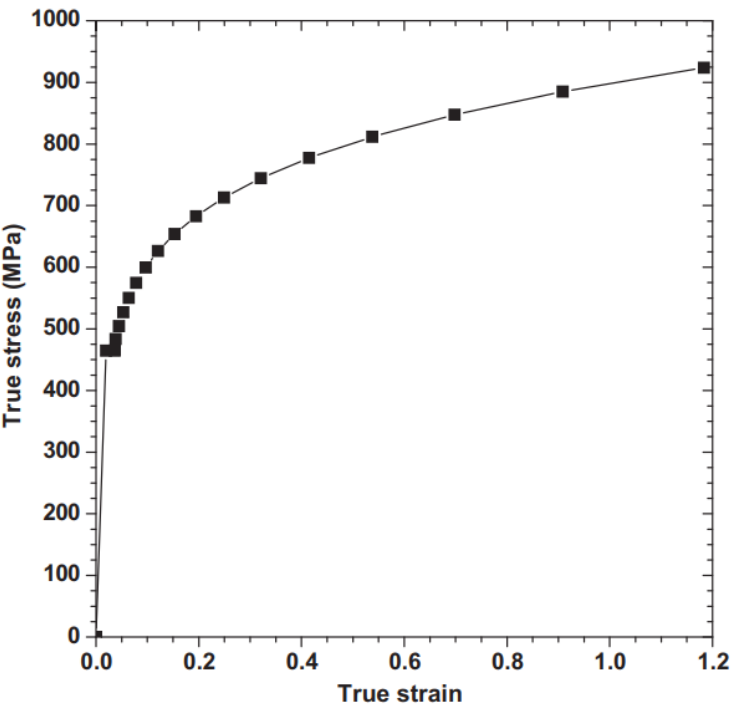
Figure 5. True stress–strain curves of X65 steel pipe [29]. Table 4. Datapoints of X65 true stress–strain inputted into ANSYS.